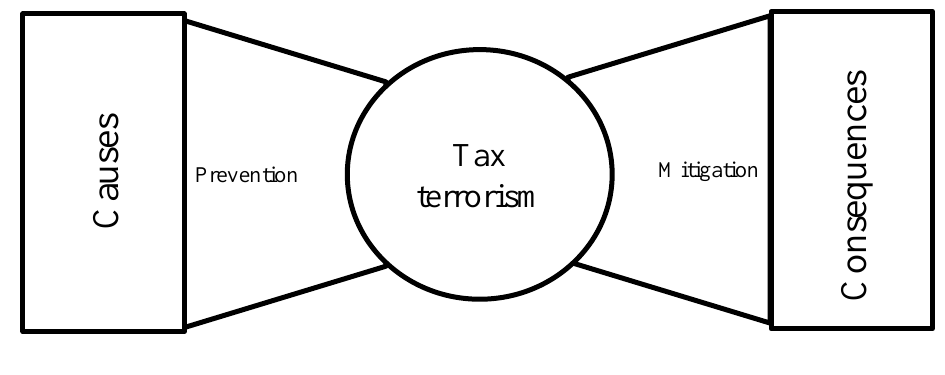
Fig. 4. The approach for fighting against tax terrorism (Developed by the